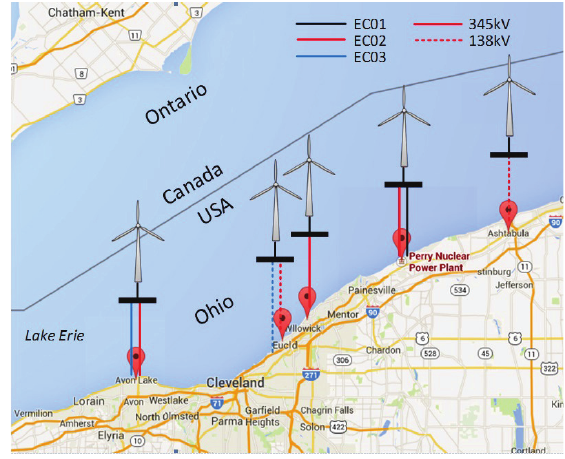
Figure 3. Map of Interconnection Scenarios into the FirstEnergy